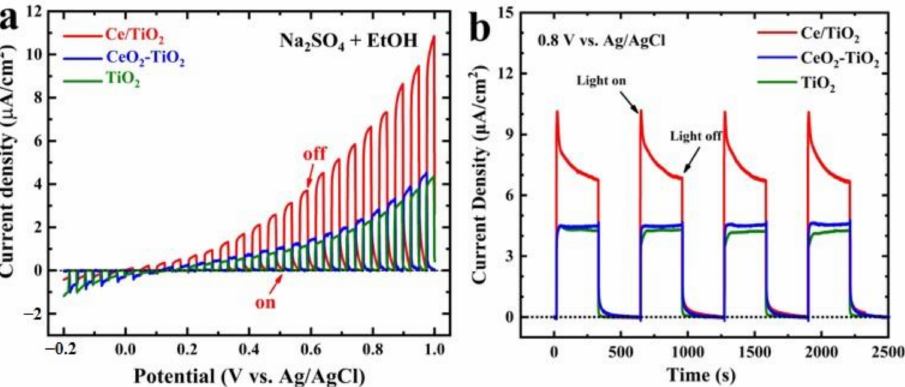
Figure 5. ( a ) Chopped linear sweep voltammetry (LSV) curves of the pure TiO 2 , CeO 2 -TiO 2 , and Ce/TiO 2 ; ( b ) chronoamperometry data plots of the pure TiO 2 , CeO 2 -TiO 2 , and Ce/TiO 2 at 0.8 V vs.